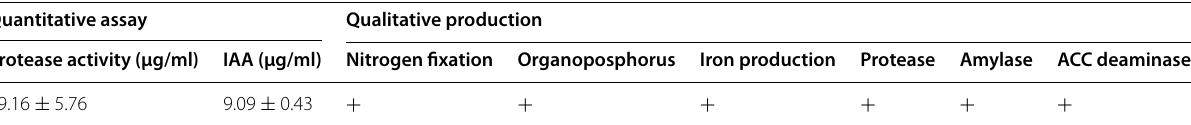
Table 6 Traits related with direct plant growth promotion